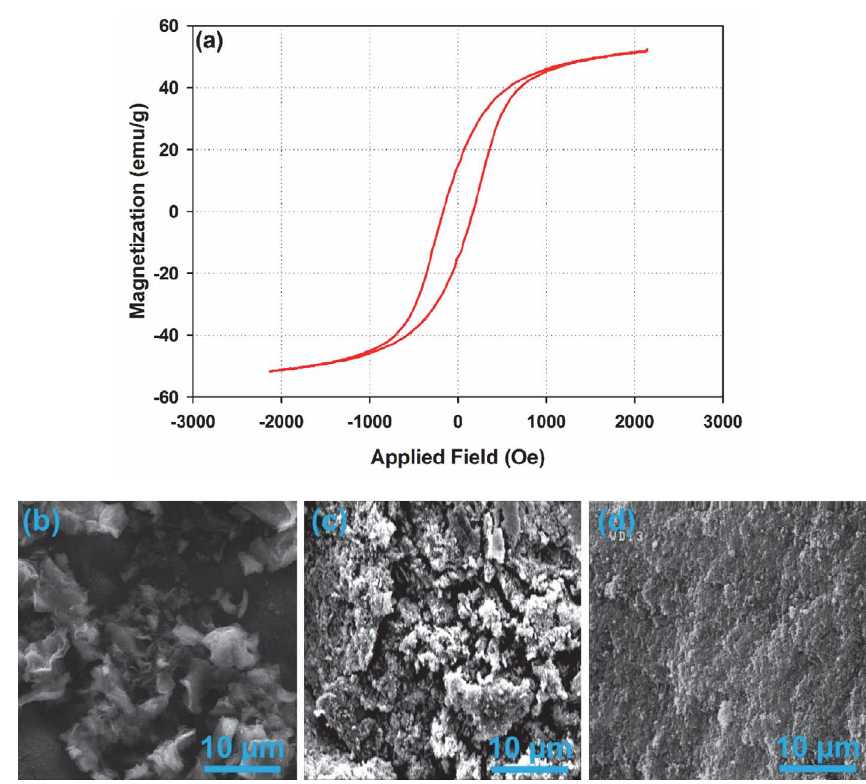
Figure 2. (a) VSM results for GO-Fe 3 O 4 nanoparticles and SEM images of (b) GO, (c) GO-Fe 3 O 4 and (d) Fe 3 O 4